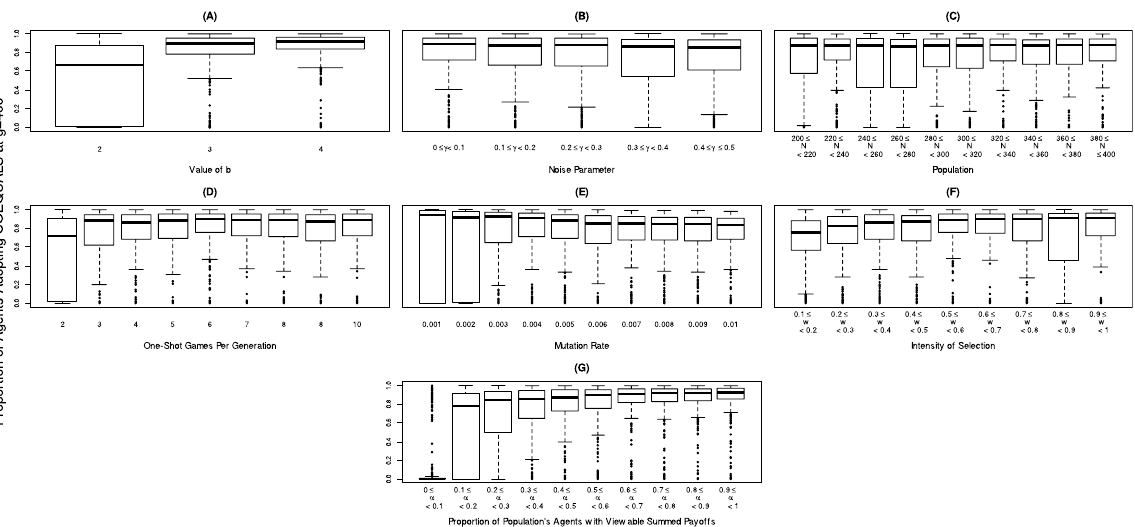
Figure 3. Proportion of population adopting COEQUALS in final generation by parameter value. Each panel displays the distributions of COEQUALS’ population shares at g = 400 across values of the parameter listed on the horizontal axis. Box plots in each panel display the median (bold center line), the upper/lower quartiles (upper/lower box edges), the non-outlier max./min. (uppermost/lowermost horizontal lines), and the outliers (hollow points) of the distributions, which are defined as observations that rest outside the interquartile range by a span greater than 1.5 times the interquartile range itself. Panel (A) shows that selection favors COEQUALS at larger values of b : the median of COEQUALS’ distribution of population shares increases noticeably when b > 2 and the lower tail of the distribution increases with every unit change of b . Varying the noise parameter has little effect on the spread of COEQUALS, however, as shown in Panel (B); across parameter ranges, the median of the distribution varies little and the shift of the distribution’s lower tail does not follow a discernable pattern. The same conclusions hold for variation across population sizes (Panel (C)) and the number of one-shot games per generation (Panel (D)). For both of those parameters, the distributions of COEQUALS’ population shares center on similar medians across all ranges of the parameter and the lower tails appear to vary arbitrarily. Panel (E) indicates that the distribution of COEQUALS’ population shares narrows with higher mutation rates, while the lower tails of the distributions increase in value. The substantive import of these changes remains relatively limited, however, as the interquartile ranges overlap substantially and the medians differ littler from each other, though they do exhibit a very slight decrease with higher mutation rates. Panel (F) indicates that the distribution of COEQUALS’ population shares varies little with the intensity of selection parameter, w . Variation in the parameter determining the proportion of other agents whose wealth a COEQUALS player can view (Panel (G)) shows the clearest trend. With every range involving higher values, both the median and the lower tail of COEQUALS’ distribution of population shares increases, albeit at a decreasing